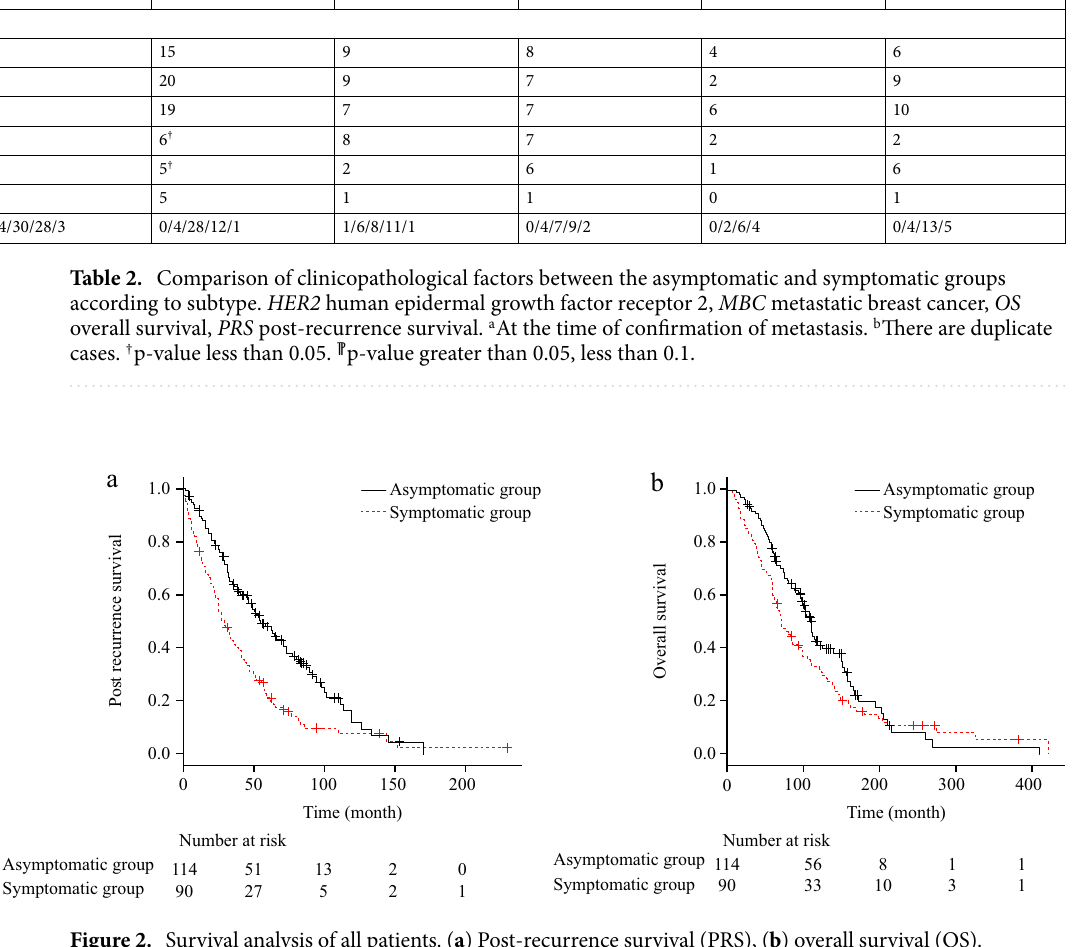
Figure 2. Survival analysis of all patients. ( a ) Post-recurrence survival (PRS), ( b ) overall survival (OS).